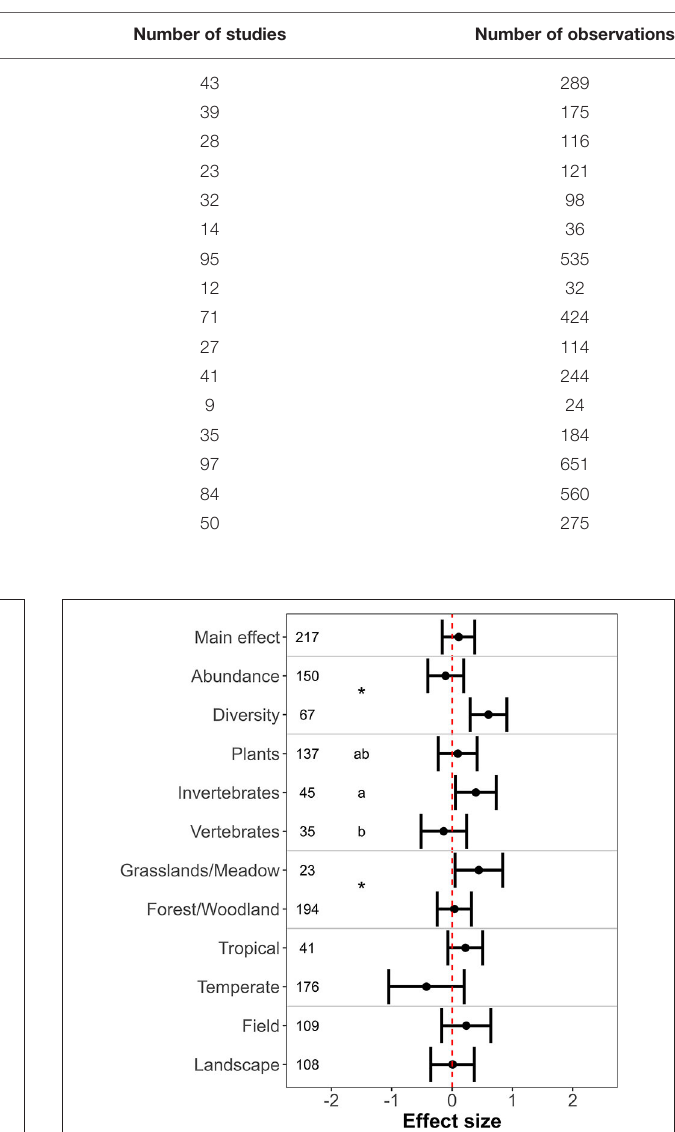
TABLE 2 | Number of studies and observations per level of each moderator and context factor.